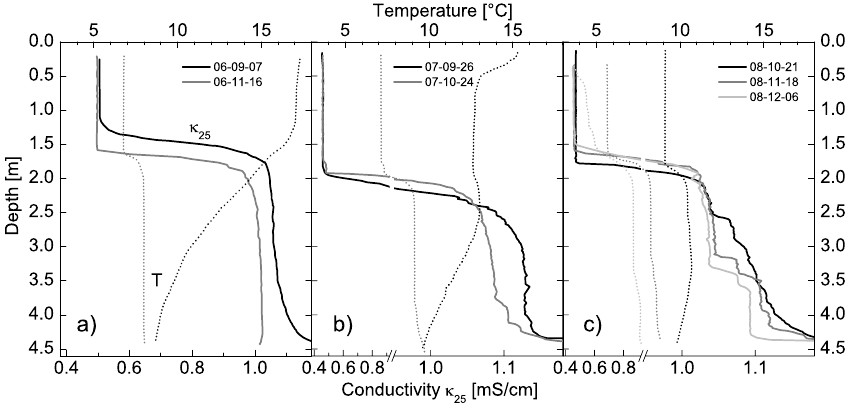
Fig. 3. Exemplary CTD-profiles at Lake Waldsee from three different years documenting variable shaping of double diffusive mixing (formation of steps) after onset of mixolimnion cooling: (a) (2006) complete overturn of the monimolimnion (= one step), (b) (2007) steps close to the bottom, (c) (2008) steps within the monimolimnion, migrating downwards with time. In panels a) and b) the preceding overall stable situations are plotted for comparison. Note the axis breaks for conductivity in panels (b) and